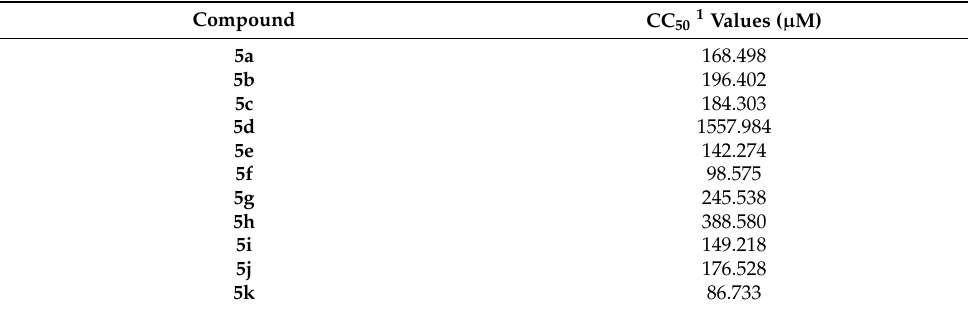
Table 1. Cytotoxicity of the amidinourea derivatives 5a – k